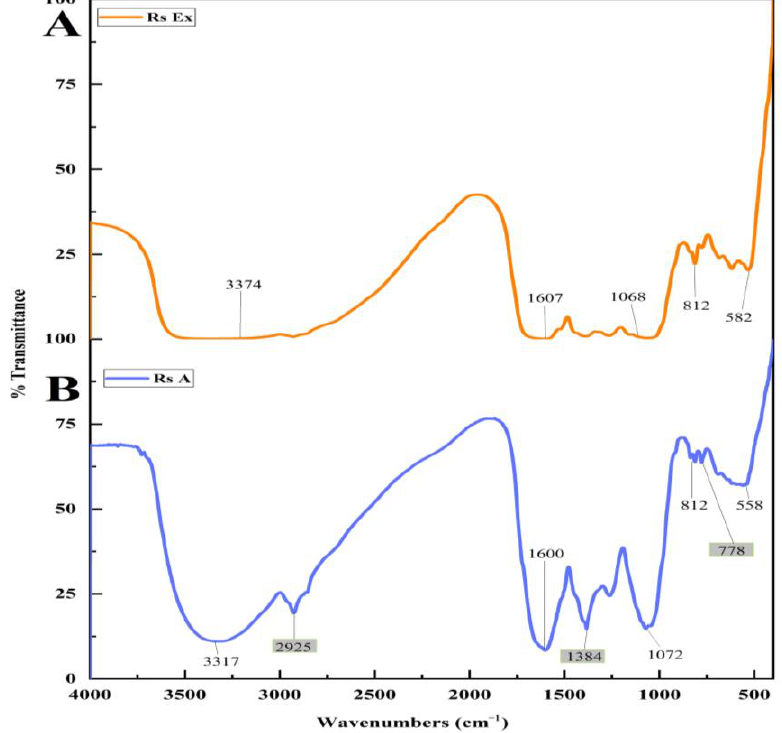
Figure 3. FTIR analysis spectrum of functional groups adsorbed on the surface of ( A ) flower bud extract and ( B ) synthesized RsFb-AgNPs. extract and ( B ) synthesized